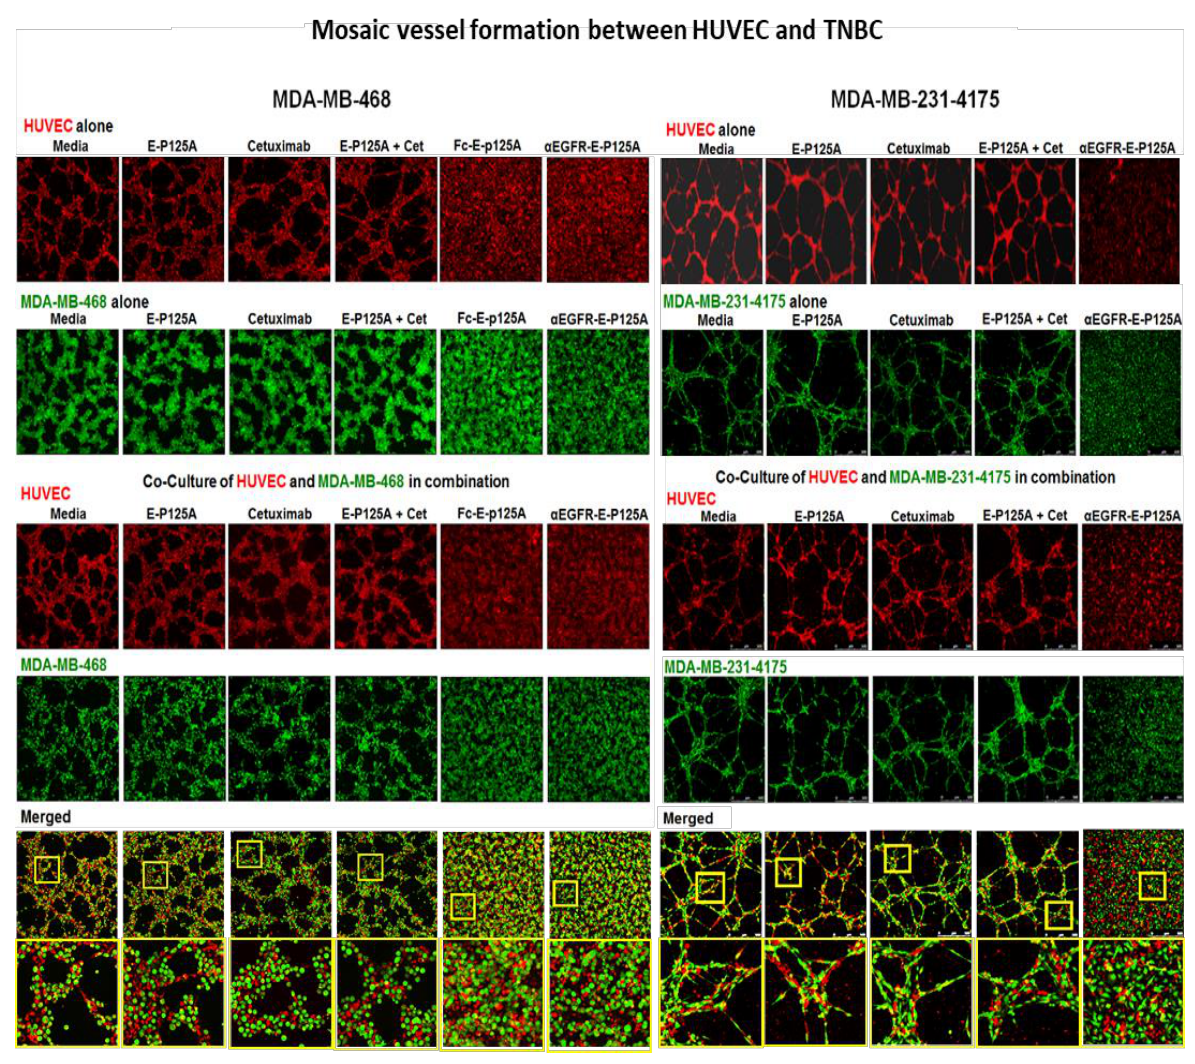
Figure 2. α EGFR-E-P125A inhibition of ‘mosaic’ vessel formation: HUVEC and TNBC co-culture. Left Panel HUVECs labeled with CellTracker™ Red CMTPX and MDA-MB-468 with CellTracker™ Green CMFDA. HUVECs (left panel, top row) in serum-free EBM2 or MDA-MB-468 (left panel, second row) in serum-free RPMI cultured alone on matrigel for 16 as indicated: α EGFR-E-P125A, or controls (media, E-P125A, cetuximab, or the combination of E-P125A and cetuximab (E-P125A + Cet)). MDA-MB-468 and HUVEC in serum-free EBM2 and RPMI co-cultured on matrigel for 16 h with indicated treatment (Left panel bottom four rows). Fluorescent imaging is shown for HUVEC (red), MDA-MB-468 (green), or both (merged). Right Panel: HUVEC and MDA-MB-231-4175 co-culture (HUVEC labeled with CellTrace™ Calcein Red-Orange AM (red) or MDA-MB-231-4175 labeled with CellTrace™ calcein green AM (green) were cultured separately on matrigel for 16 h and treated with α EGFR-E-P125A or controls [media, E-P125A, cetuximab, or E-P125A and cetuximab combined (E-P125A + Cet)]. (Right panel, top two rows). Labeled MDA-MB-231-4175 and HUVEC cocultured on matrigel (Rightpanel, bottom 4 rows). Labelled MDA-MB-231-4175 and HUVEC co-cultured on matrigel 16 h and treated as indicated Images taken with a Leica fluorescence confocal microscope. (Left and Right bottom panels): Higher magnification views are provided of areas highlighted in yellow bordered squares below the coculture figures in the, demonstrating the alignment and coalescence of HUVEC (red) and TNBC cells (green) in mosaic vessels, as well as the more random distribution of HUVEC and TNBC in cocultures exposed to α